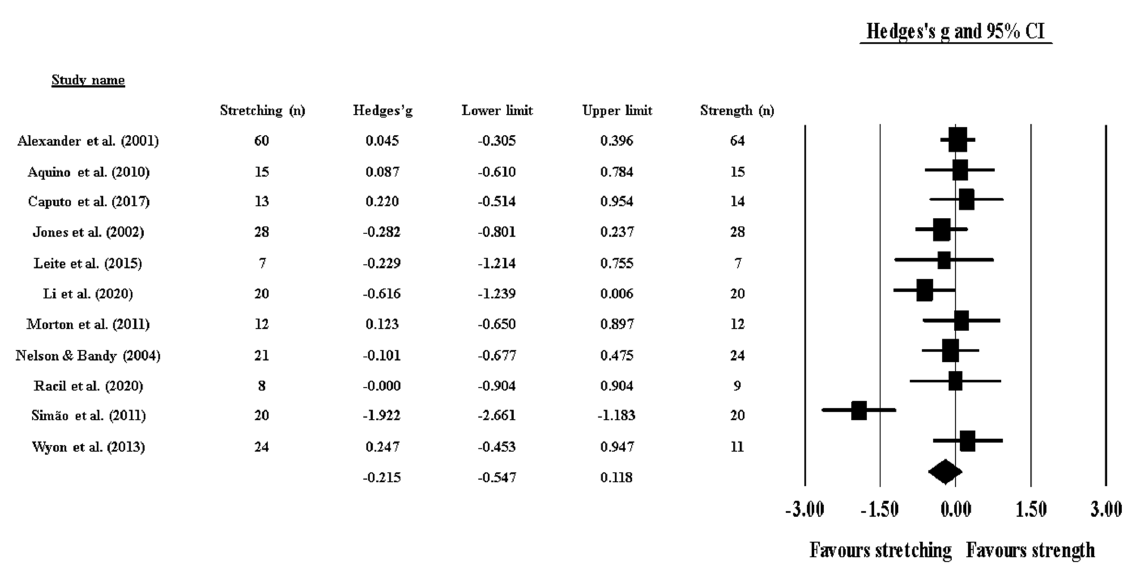
Figure 2. Forest plot of changes in ROM after participating in stretching-based compared to Scheme 95. confidence intervals (CI). The size of the plotted squares reflects the statistical weight of the study.